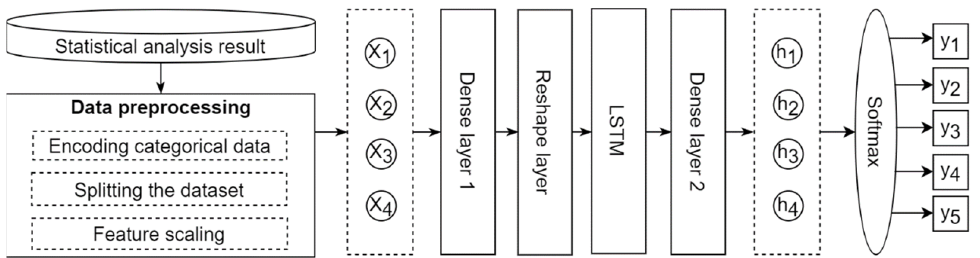
Figure 6. Procedure for applying LSTM to decide